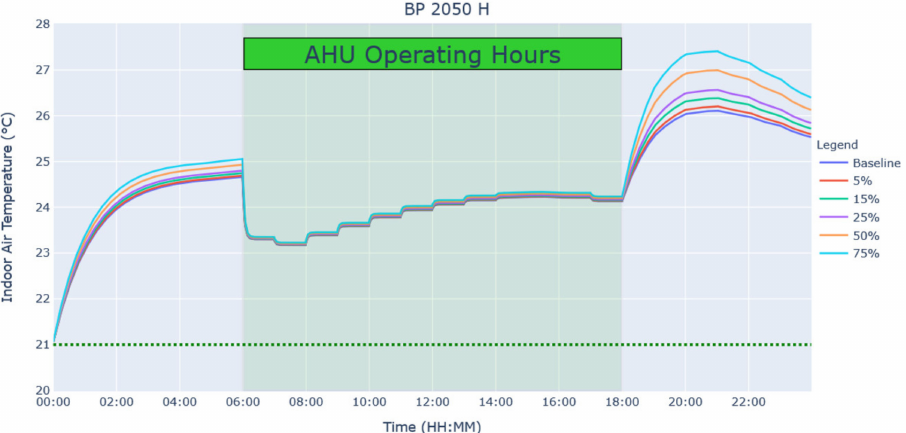
Figure 7. Daily internal air temperature profile for model sensitivity analysis of Budapest 2050 hottest day data, with AHU operating hours highlighted by green shaded